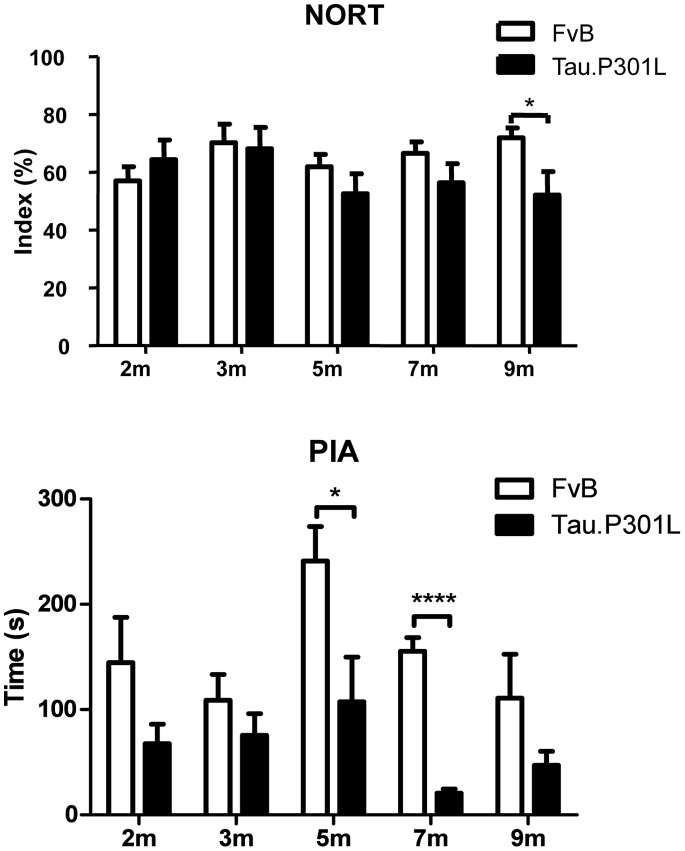
Defective cognition of Tau.P301L mice at different ages.Analysis by novel object recognition (ORT) (upper panel) and passive inhibitory avoidance (PIA) task (lower panel) of Tau.P301L mice at age 2 to 9 months compared to age-matched wild-type FvB mice. Student t-Test, unpaired, two-tailed, n = 8 per age group. *p<0.05, ****p<0.0001.